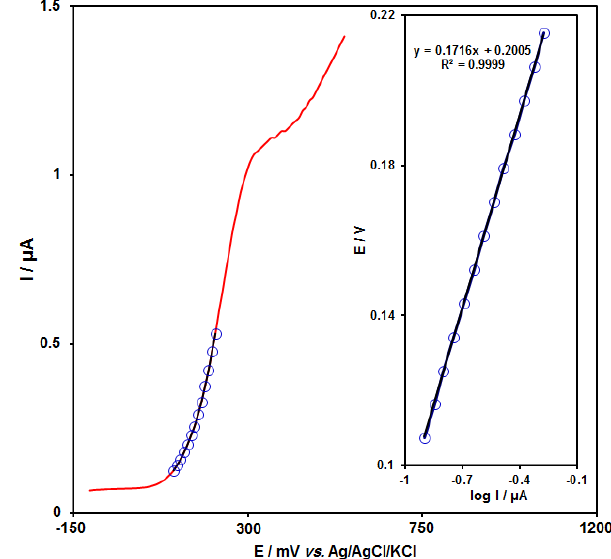
Fig. 6. LSV (at 10 mV s −1 ) of electrode in 0.1 M PBS (pH 7.0) containing 100.0 µM paracetamol. The points are the data used in the Tafel plot. The inset shows the Tafel plot derived from the LSV